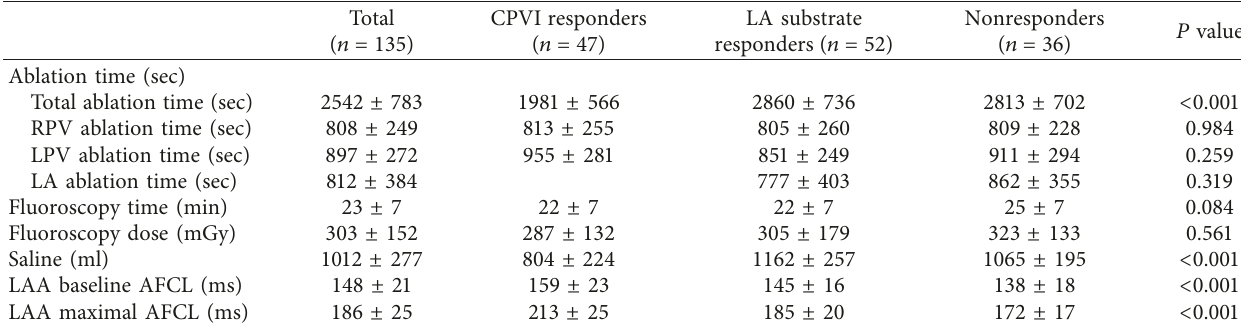
Table 2: Procedural